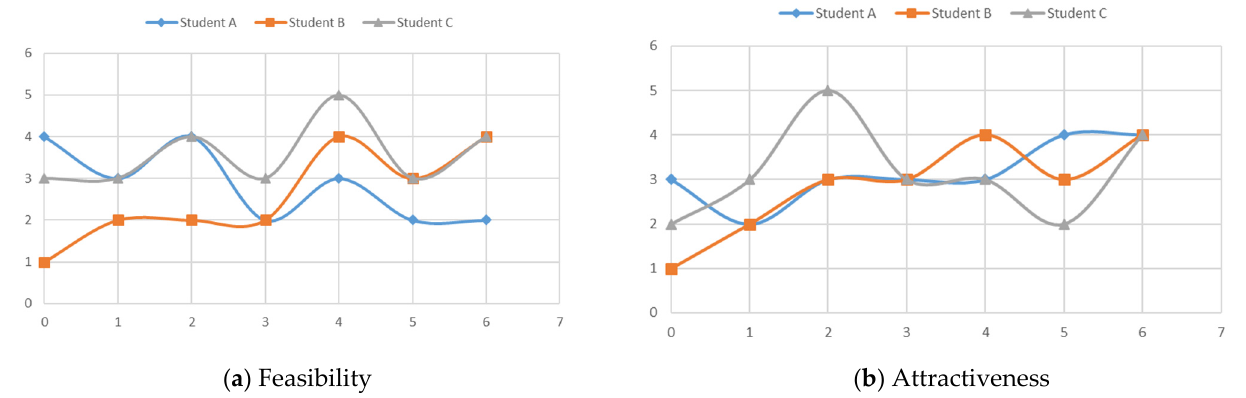
Figure 4. Dynamics of perception of opportunity ( a ) feasibility and ( b ) attractiveness by three students along the entrepreneurial journey on Likert scale 1–5 (min–max). Checkpoints 0–6 correspond to Table 1.